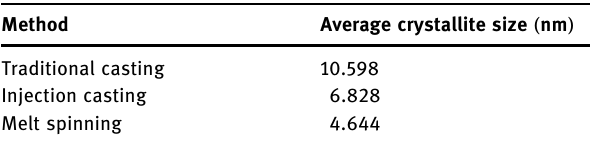
Table 3: Statistics of average crystallite size under three